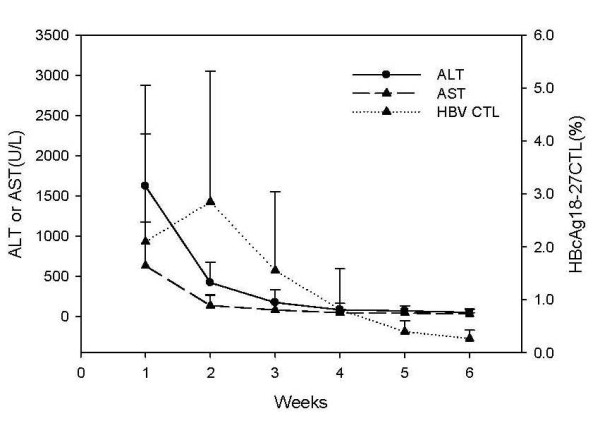
Relationship between the frequency of peripheral blood HBcAg18-27-specific CTLs and liver injury in AHB patients. Liver function tests (ALT and AST) were measured in hospitalized AHB patients.